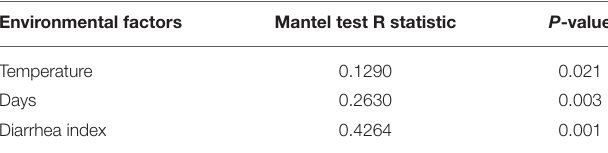
TABLE 2 | Mantel test of environmental factors in pig